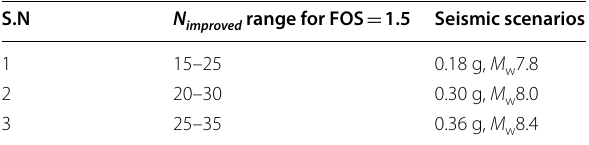
Table 4 Improved SPT-N ( N ) range for FOS of 1.5 to improved ascertain no liquefaction during three seismic scenarios